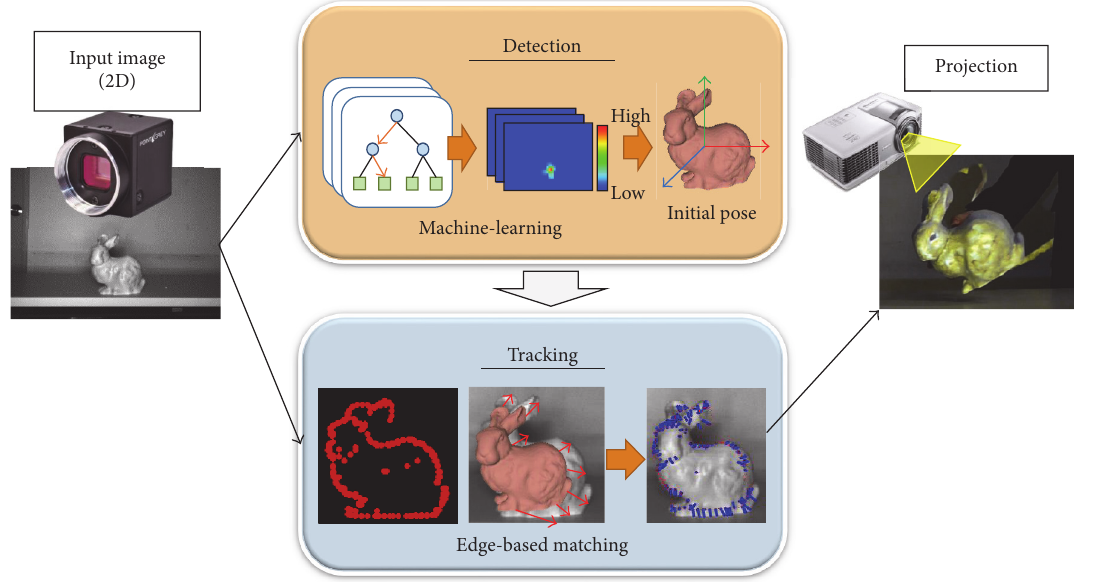
Figure 1: Process flow of the proposed dynamic SAR with an IR